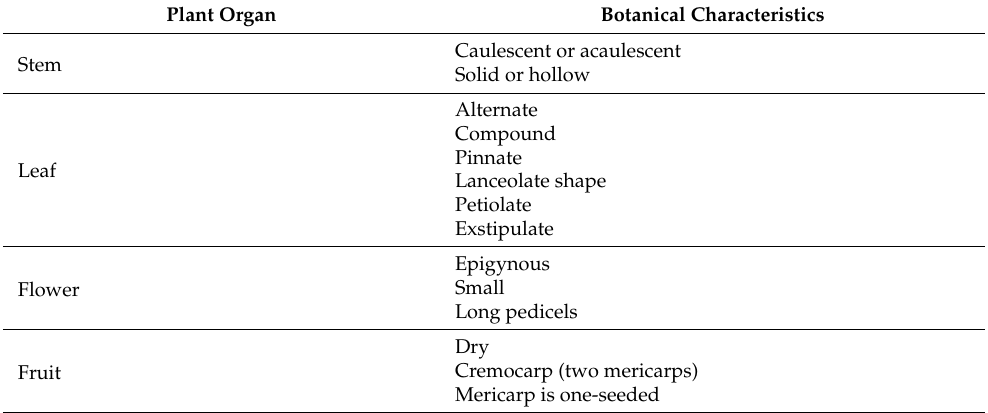
Table 1. Botanical characteristics of genus Angelica